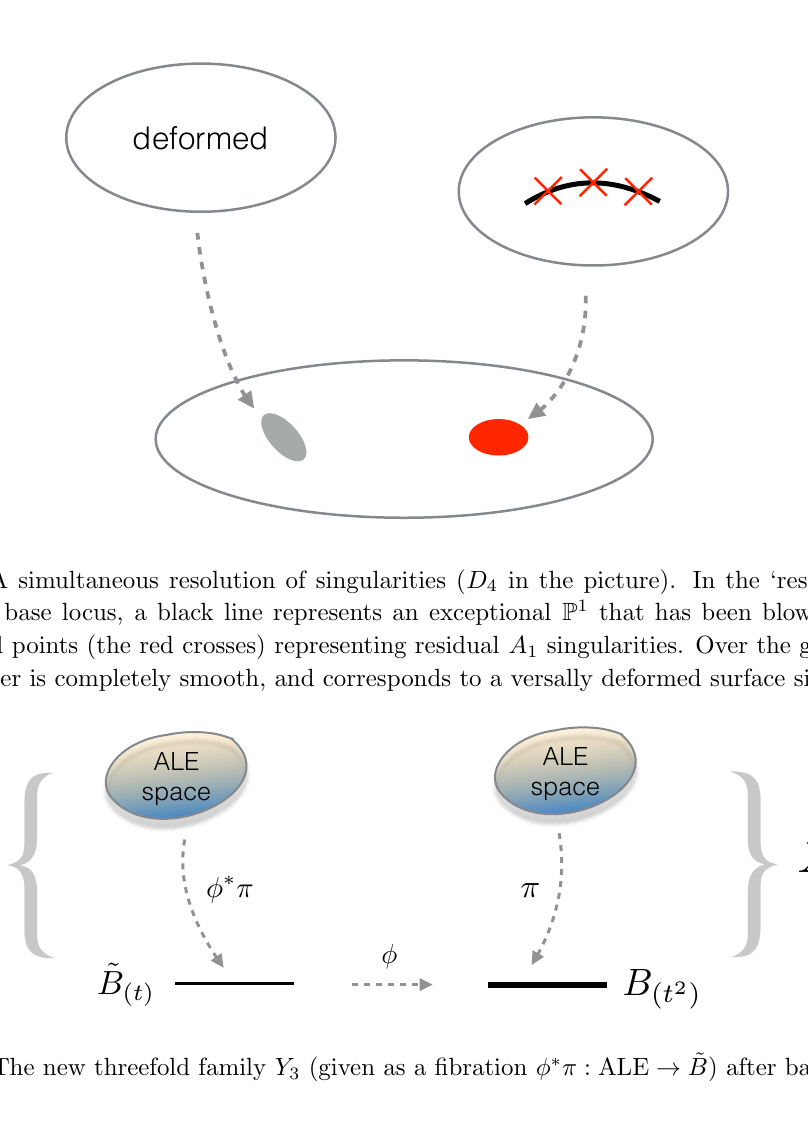
3 (given as a (cid:12)bration (cid:30) (cid:3) (cid:25) : ALE !